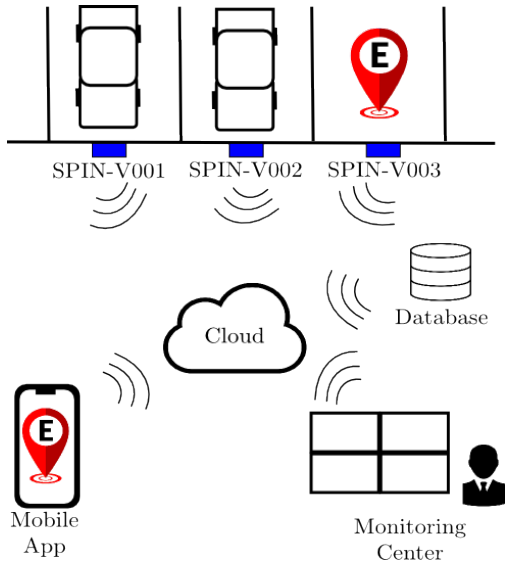
Figure 1. Smart parking system